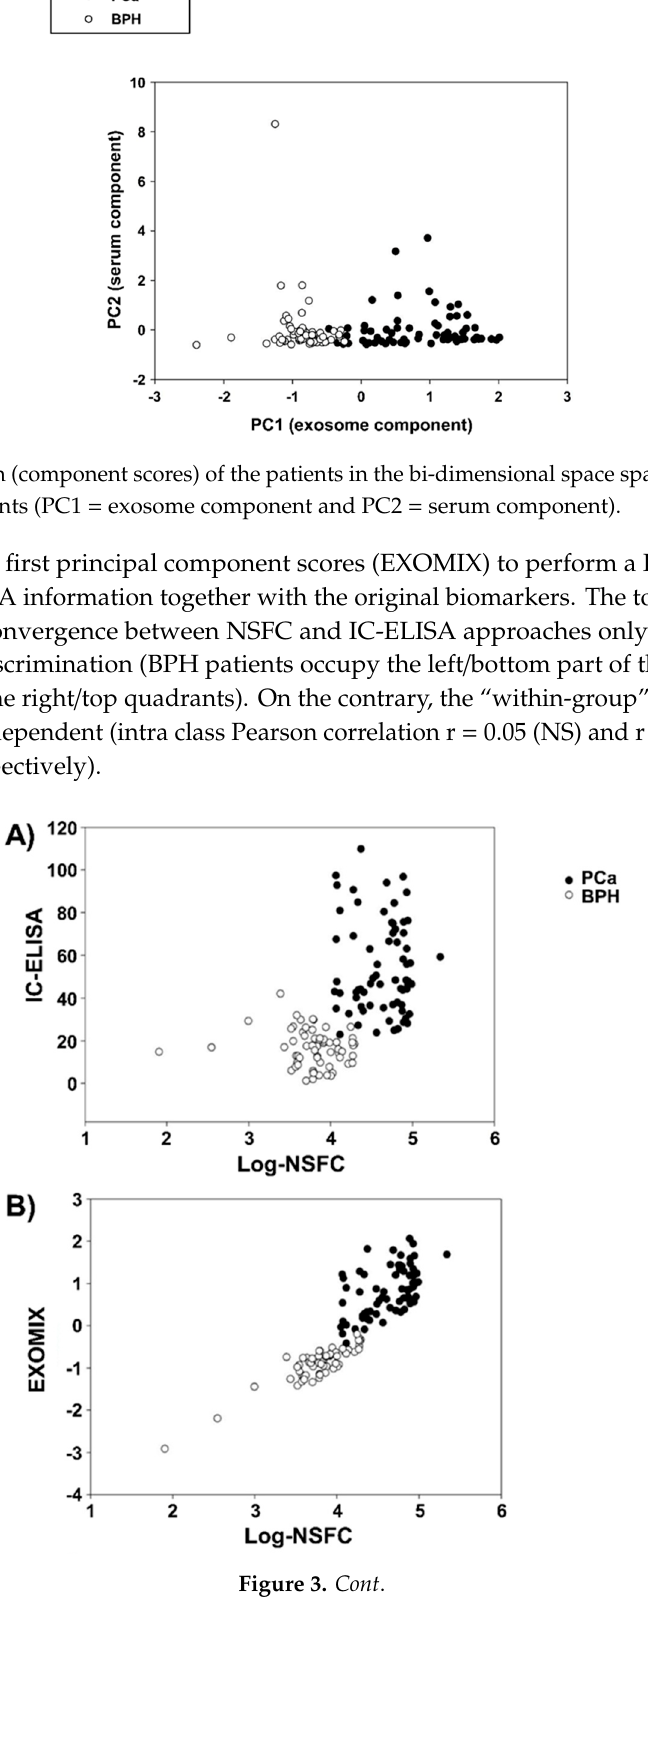
Figure 3. Nanoscale flow-cytometry (NSFC)/IC-ELISA original plane ( A ) together with the relations between the combined score (EXOMIX) with the exosome biomarkers ( B and C ). Table 1. ROC Analysis of Different Methods. Biomarker